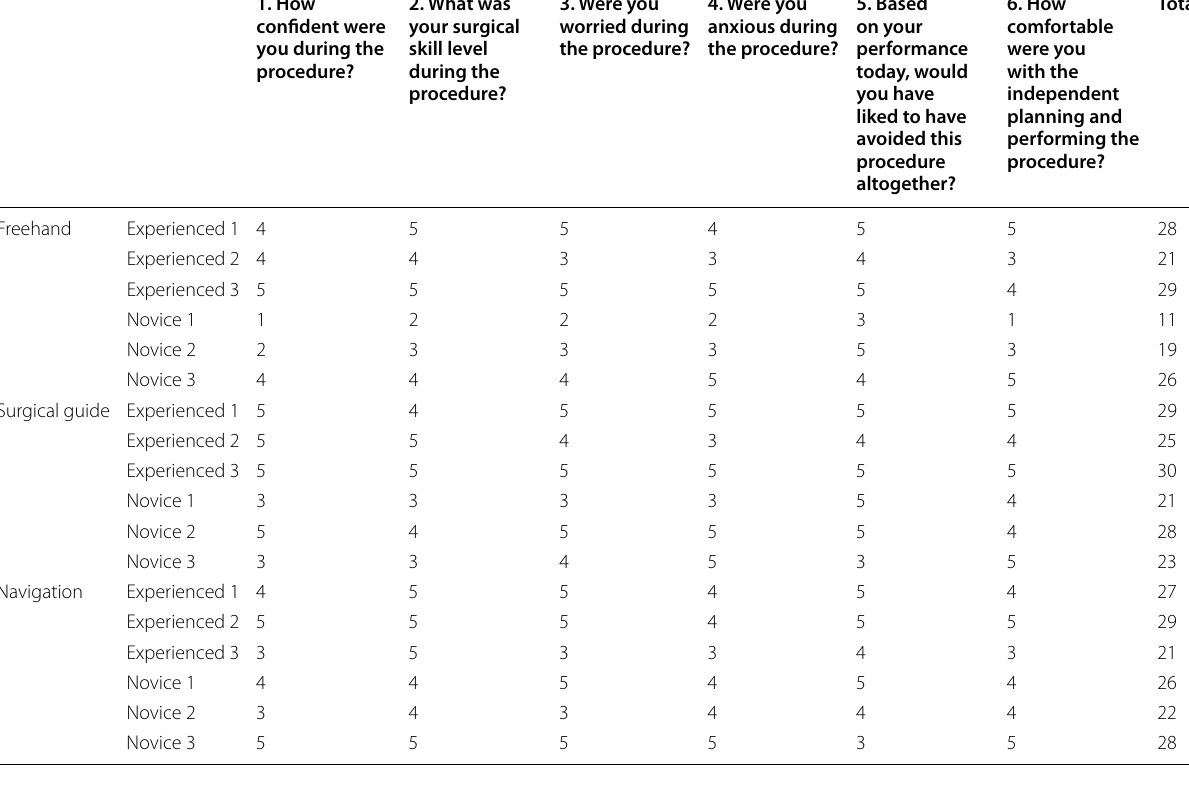
Table 3 Self-confidence scoring of each practitioner